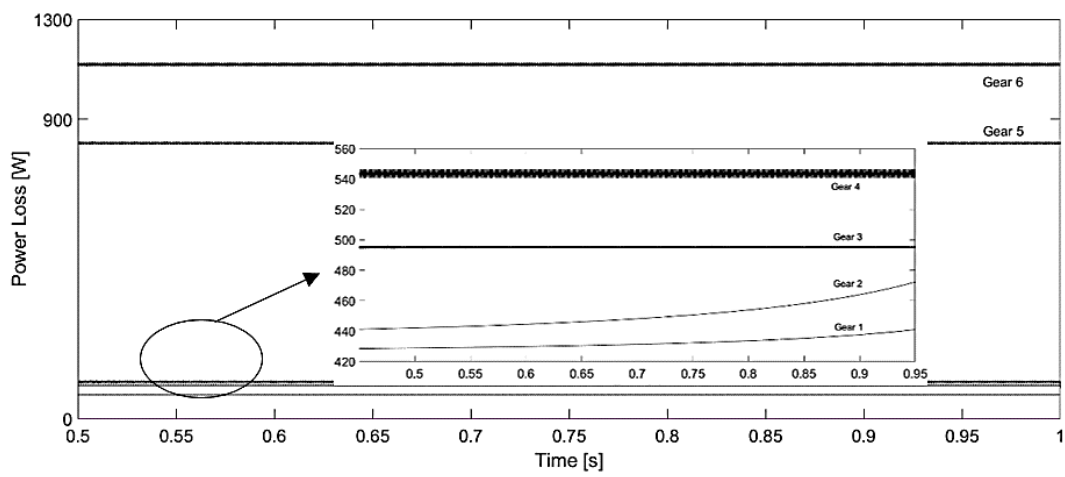
Figure 14. Power losses for DLC-coated gears, scenario 2.